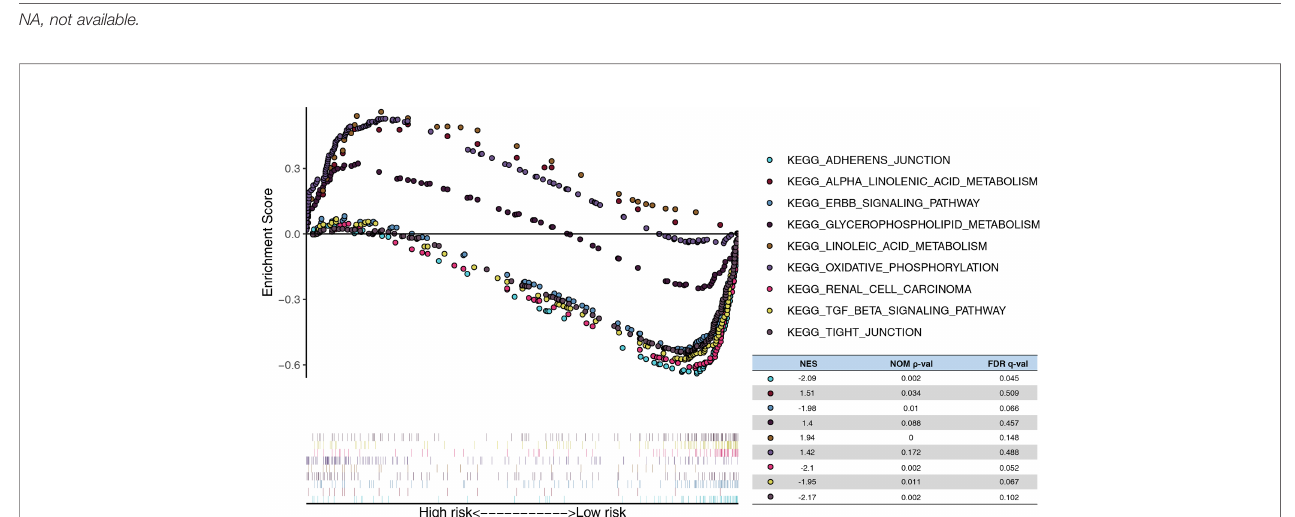
FIGURE 6 | Functional analysis of the risk model. GSEA analysis between high- and low-risk in TCGA. NES, normalized enrichment score; Nom, nominal; FDR, false discovery rate.